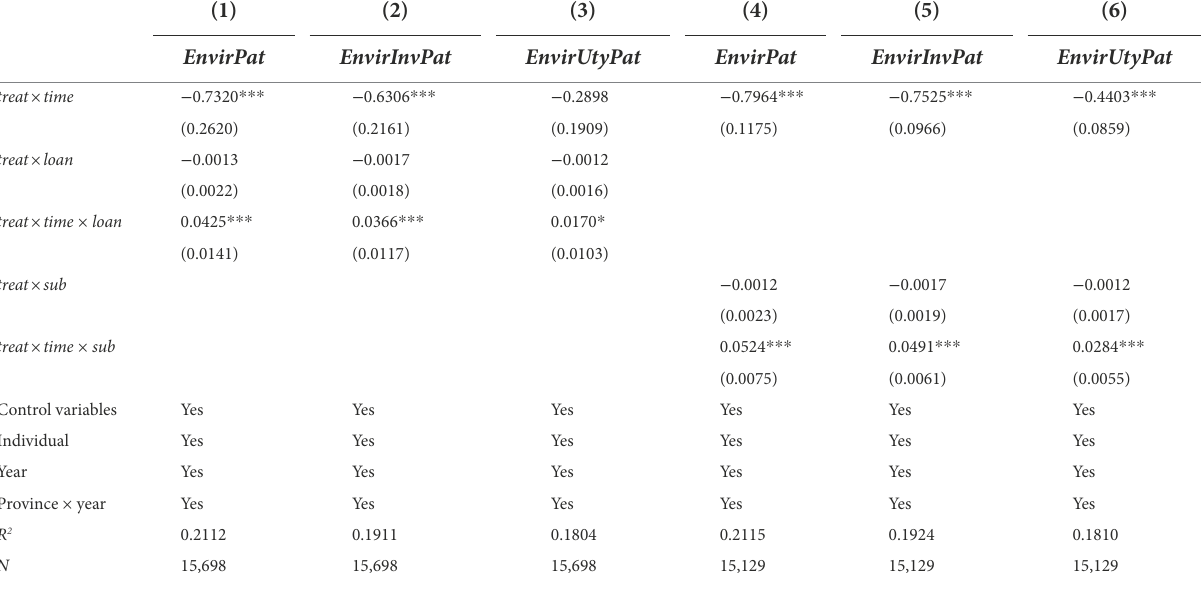
TABLE 6 Credit and Government Subsidy Mechanism